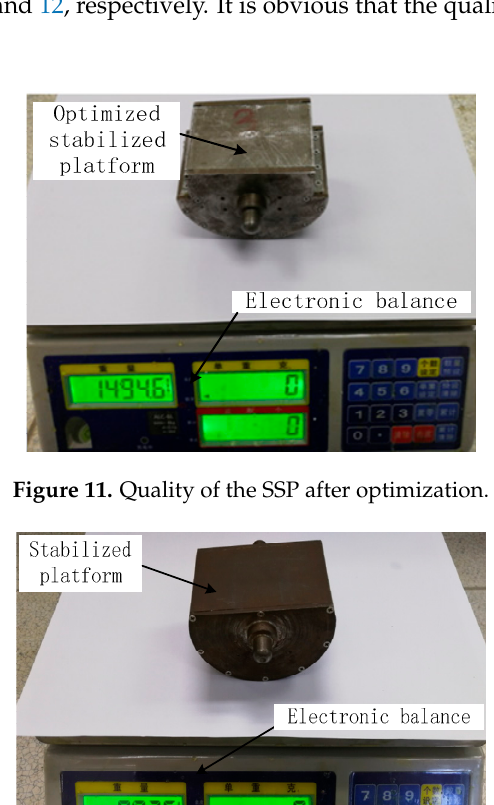
Figure 10. Curves of the roll angular rate and the roll angle of the SSP change with the quality: ( a ) A curve of roll angular rate and roll angle vary with time when the quality of the SSP is 1029.97 g; ( b ) A curve of roll angular rate and roll angle vary with time when the quality of the SSP is 1492.67 g; ( c ) A curve of roll angular rate and roll angle vary with time when the quality of the SSP is1681.18 g; ( d ) A curve of roll angular rate and roll angle vary with time when the quality of the SSP is1875.09 g